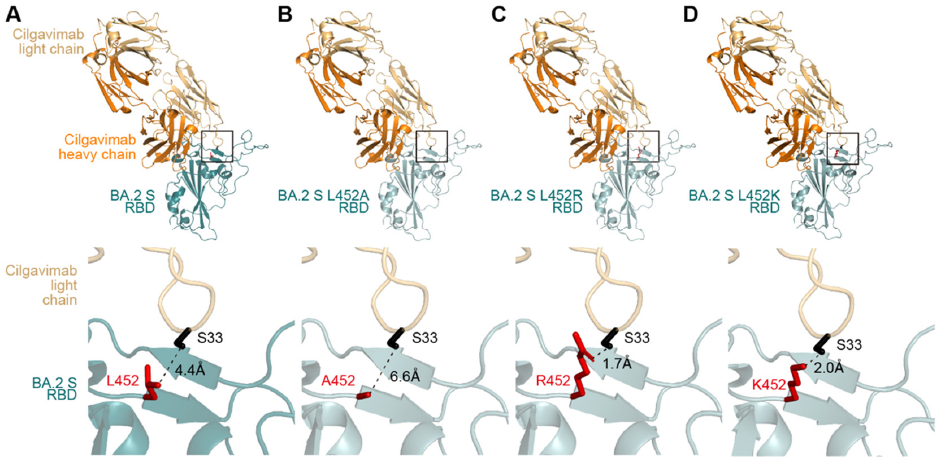
Figure 1. Structural insights of the complex of cilgavimab and the SARS ‐ CoV ‐ 2 spike RBD of BA.2 ( A ), BA.2 L452A ( B ), BA.2 L452R ( C ), and BA.2 L452K ( D ). The squared regions are enlarged in the bottom panels. The residue at position 452 of each BA.2 spike RBD mutant is shown in red, while the serine residue at position 33 (S33) of the cilgavimab light chain is shown in black. The distance between these two residues is shown in the panels.